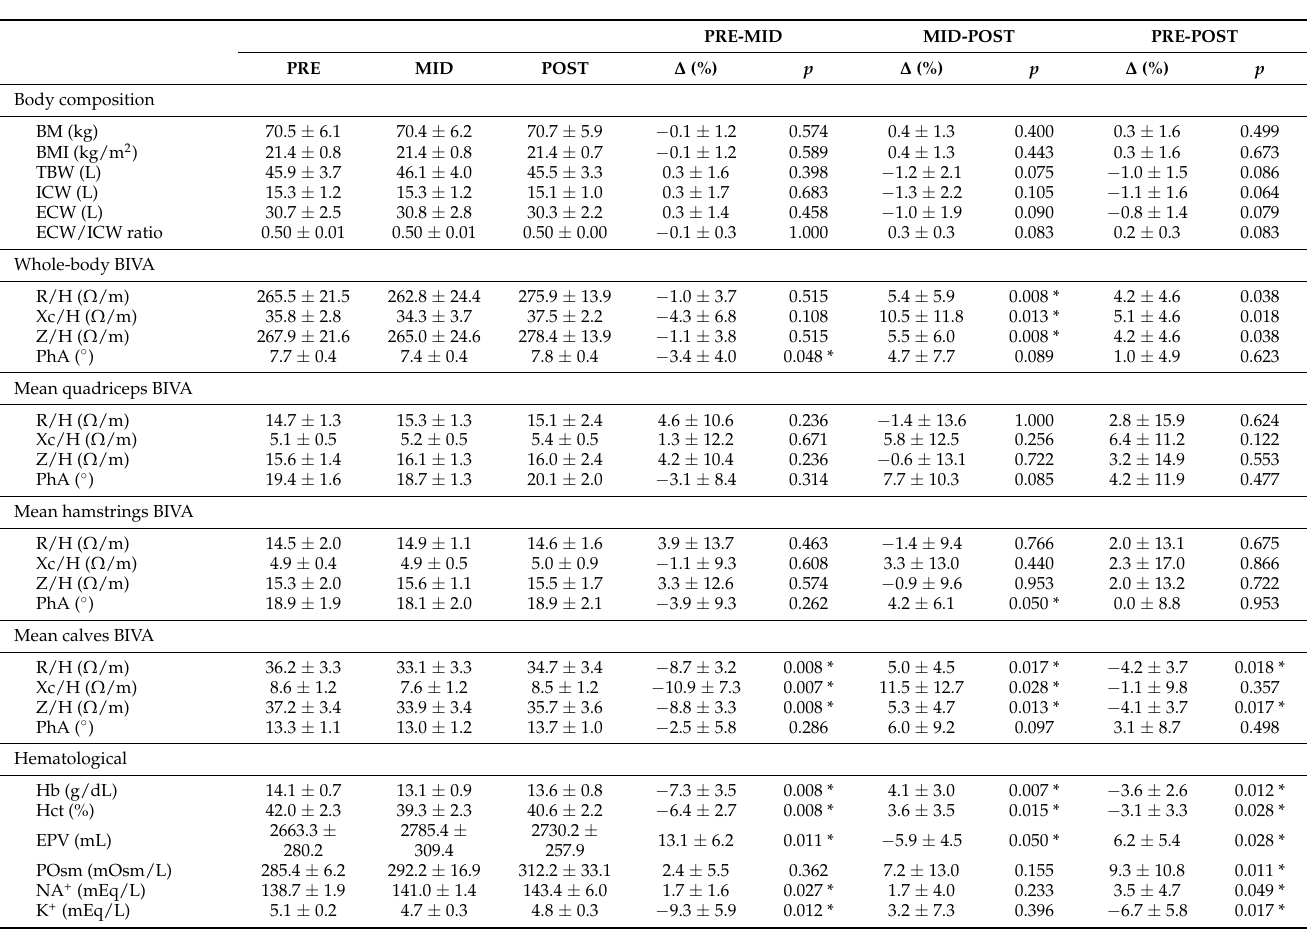
Table 2. Hematological, anthropometric, and bioelectrical changes of elite cyclists during the Giro d’Italia